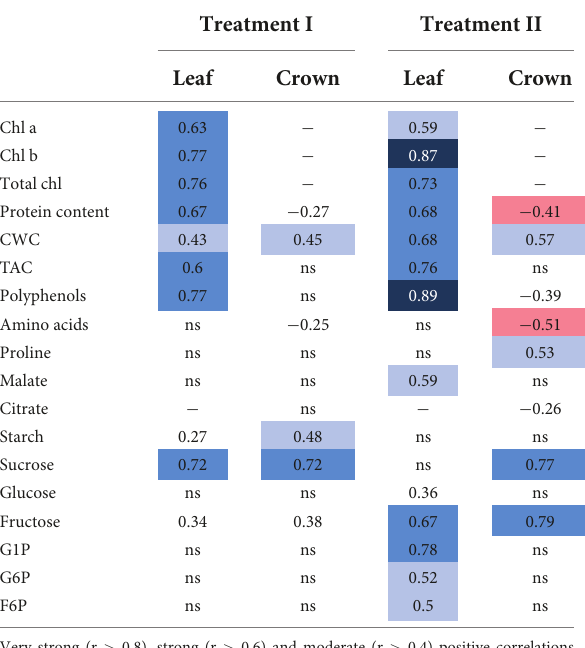
TABLE 1 Spearman coefficients ( r -values) of metabolites against GLA throughout CA, DEA, and